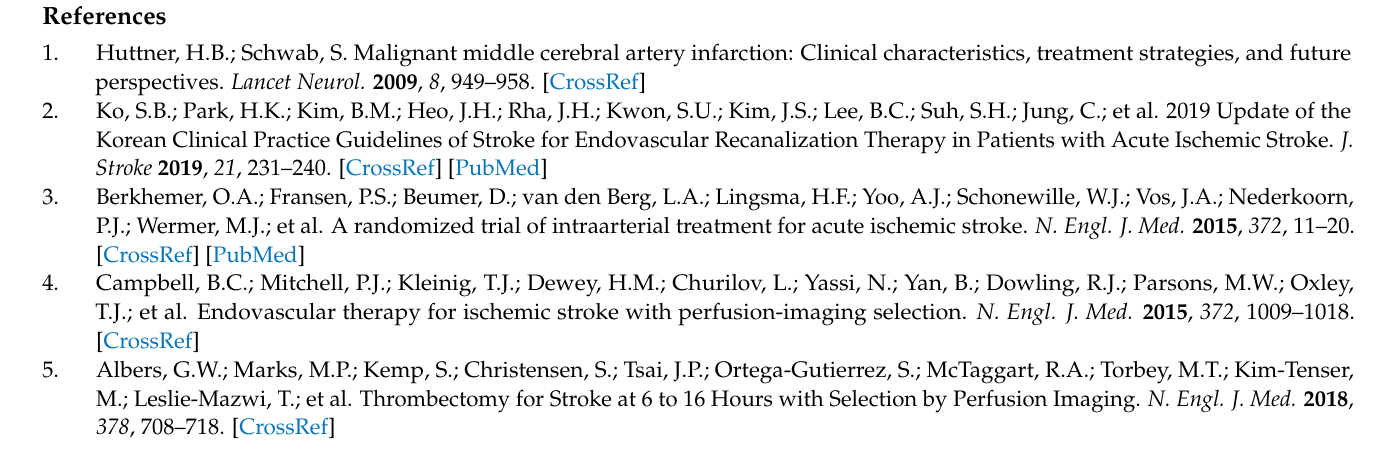
with the unfavorable outcome among 404 patients with EVT (Model 2). Table S3: Multivariate analysis for stroke risk score correlated with the unfavorable outcome among successful recanalization patients (Model 1). Table S4: Clinical and imaging characteristics according to the degree of clinical outcome after EVT (AF-related stroke and non-AF-related stroke). Table S5: Multivariate analysis for stroke risk score correlated with the unfavorable outcome in patients with AF-related stroke (Model 1). Table S6: Comparison of area under curve (AUC) of each stroke risk score by two. (Univariate ROC analysis). Table S7: Comparison of area under curve (AUC) of each stroke risk score by two in successful recanalization patients. (Univariate ROC analysis). Table S8: ROC curve analysis (AUC), NRI, and IDI of predictive models for unfavorable outcome in EVT